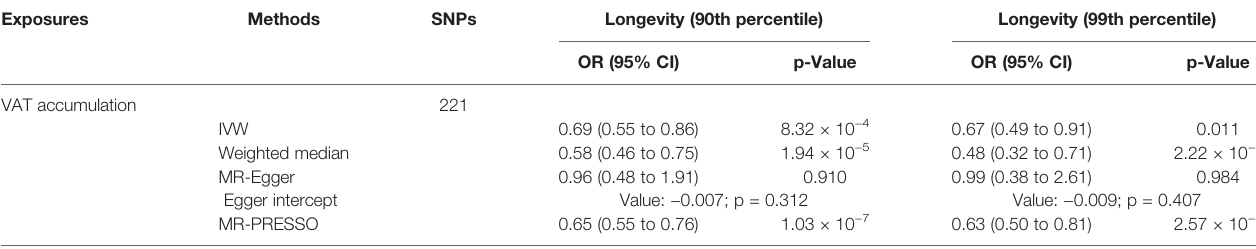
TABLE 1 | Mendelian randomization association between genetically determined VAT accumulation and longevity. Exposures